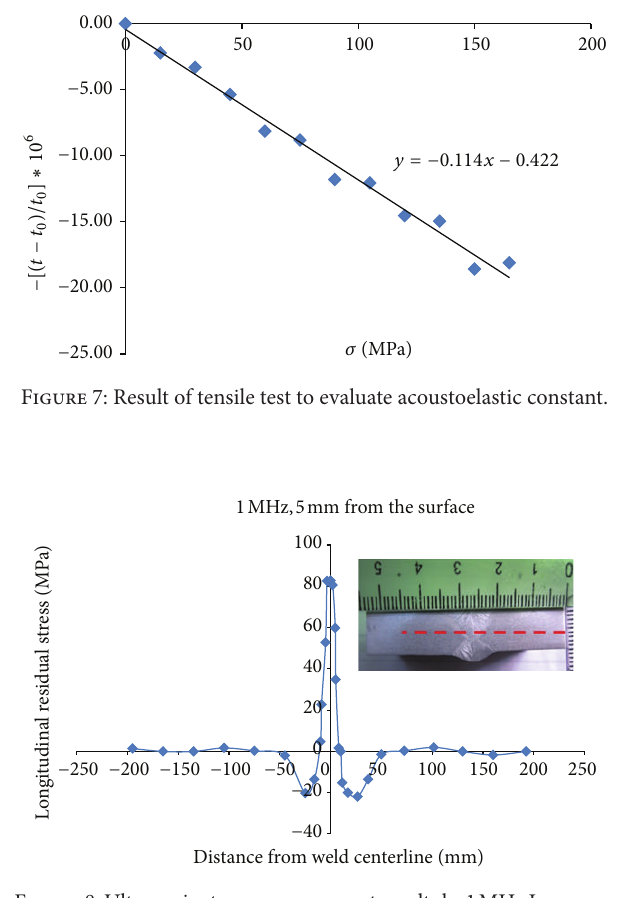
Figure8:Ultrasonicstressmeasurementresultsby1 MHzL CR wave.